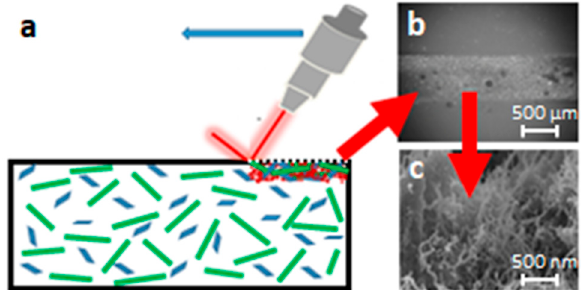
Figure 1. Effect of laser ablation on the surface ( a ); SEM micrographs at different magnifications of resulting tracks showing increased content of conductive filler ( b , c ).